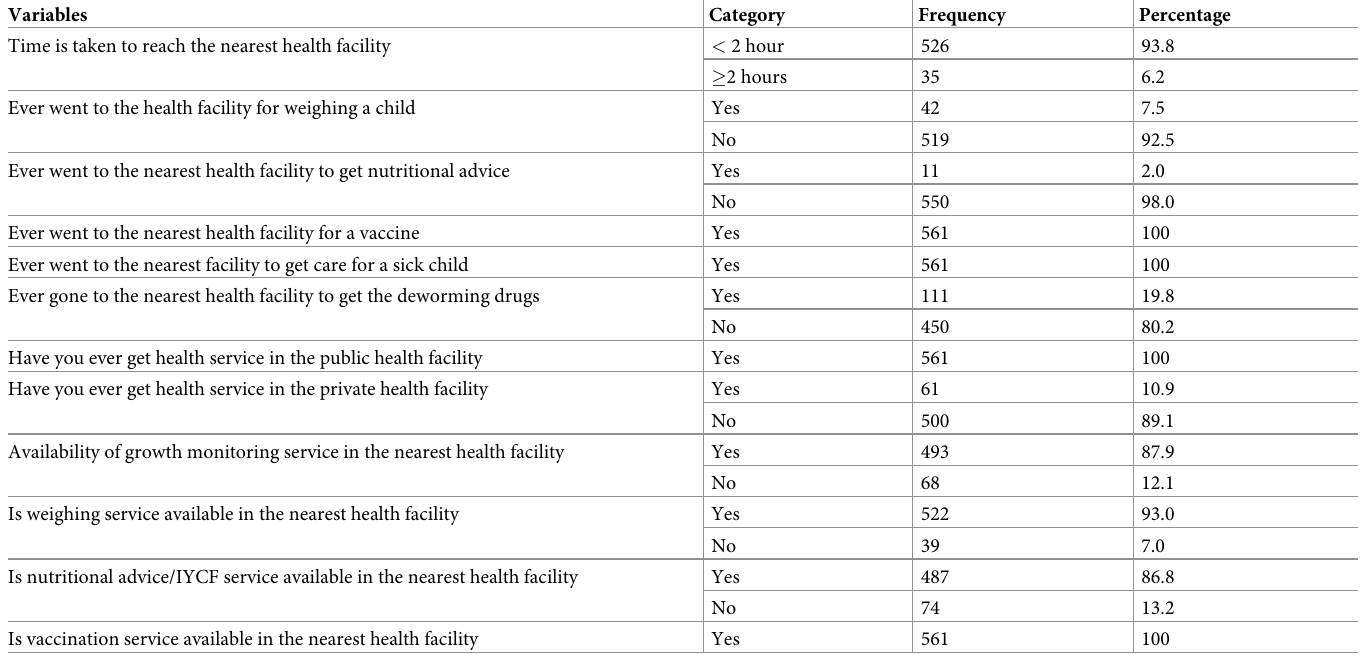
Table 6. Accessibility of health facility for mothers/ caregivers in Banja District, Northwest Ethiopia, 2020 (n = 561).